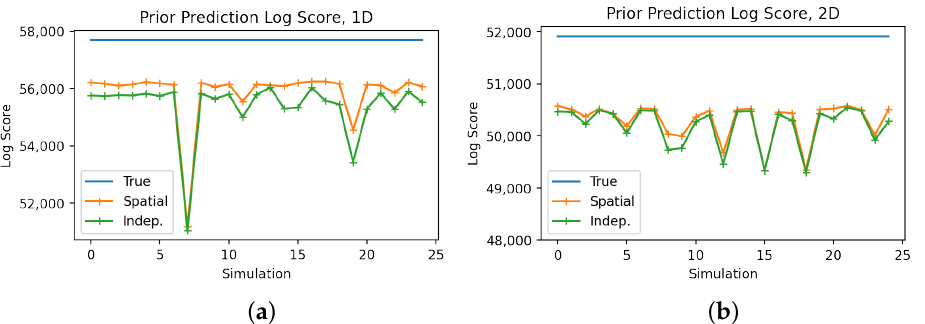
Figure 5. Prior score plots for 25 simulated realizations. The posterior estimates for the spatial model are usually closer to their priors than the independent models. The effect is weaker for the 2D case, suggesting that the improvement tends to be most pronounced with highly correlated data. ( a ) Prior score results for a 1D array of 10 pixels. ( b ) Prior score results for a 2D grid of 9 pixels.